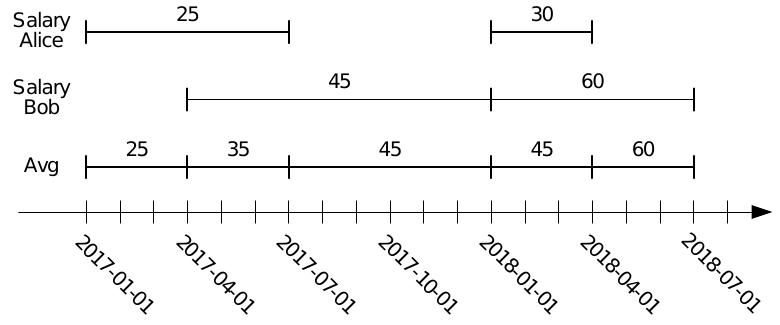
Figure 2. Example of the temporal average